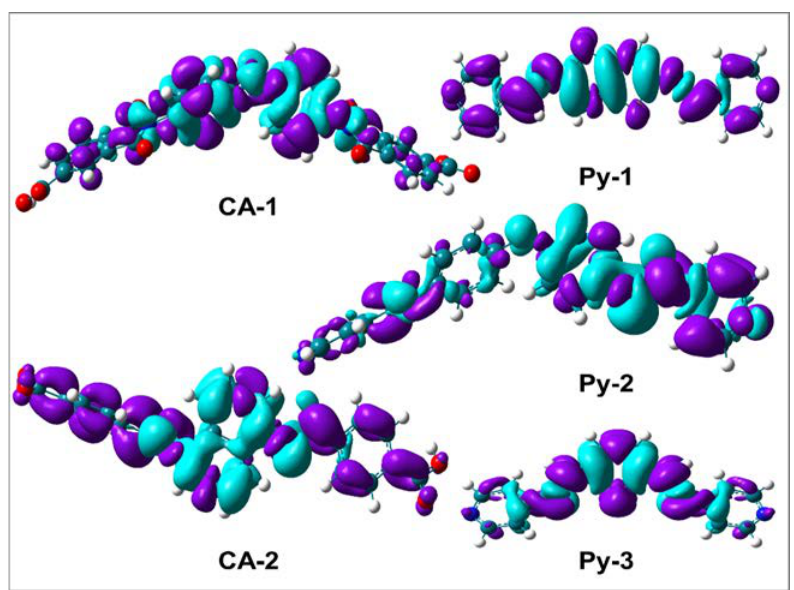
Figure 7. Isosurface of charge density difference (CDD) map. Purple and cyan correspond to electron and hole. Table 4. Charge transfer descriptors and ∆ q, the net number of charge transferred to the anchor.